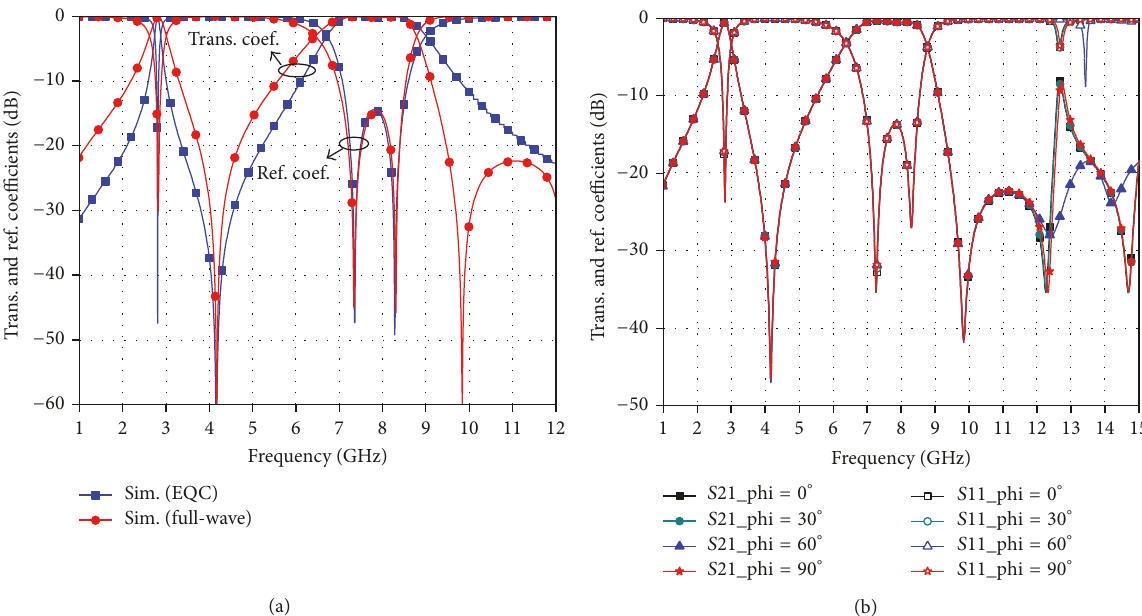
Figure 4: (a) Comparison of transmission and reflection coefficients of the dual-band FSS calculated by CST and the equivalent circuit. (b) Transmission coefficients of the FSS under different